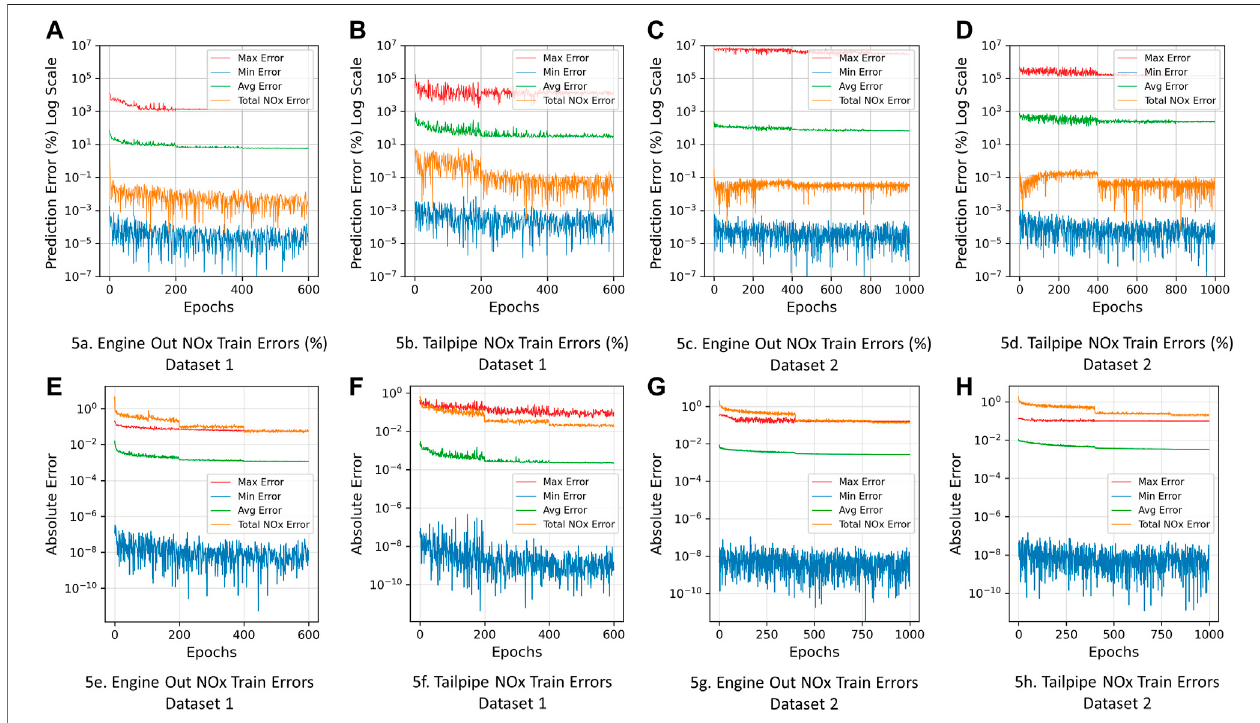
FIGURE 5 | Progression of total NO x error in comparison with maximum, minimum and mean absolute error over training of all DNN NO x models. (A) Engine Out NOx Train Errors (%) Dataset 1. (B) Tailpipe NOx Train Errors (%) Dataset 1. (C) Engine Out NOx Train Errors (%) Dataset 2. (D) Tailpipe NOx Train Errors (%) Dataset 2. (E) Engine Out NOx Train Errors Dataset 1. (F) Tailpipe NOx Train Errors Dataset 1. (G) Engine Out NOx Train Errors Dataset 2. (H) Tailpipe NOx Train Errors Dataset 2.